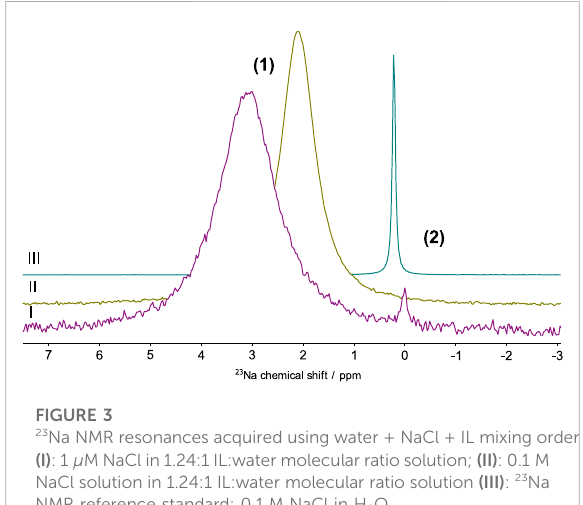
(I) : 1 μ M NaCl in 1.24:1 IL:water molecular ratio solution; (II) : 0.1 M NaCl solution in 1.24:1 IL:water molecular ratio solution (III) : 23 Na NMR reference standard: 0.1 M NaCl in H 2